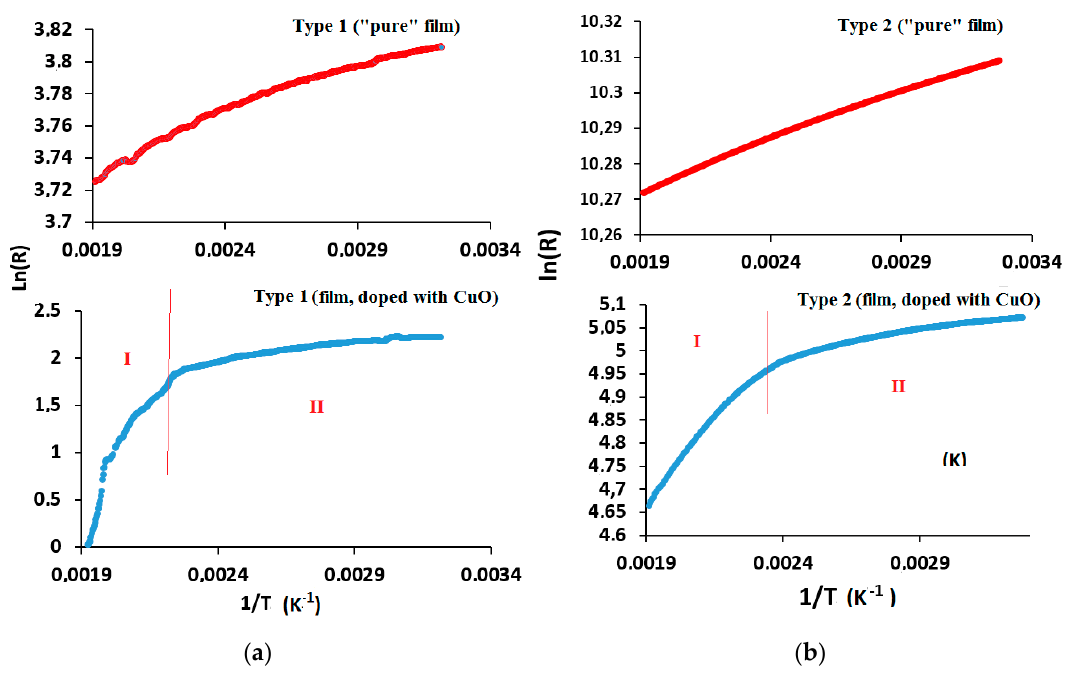
Figure 11. Dependence of ln(R) on the 1/T or the gas sensor chips: ( a ) type-1 and ( b ) type-2. R denotes resistance, T denotes temperature.